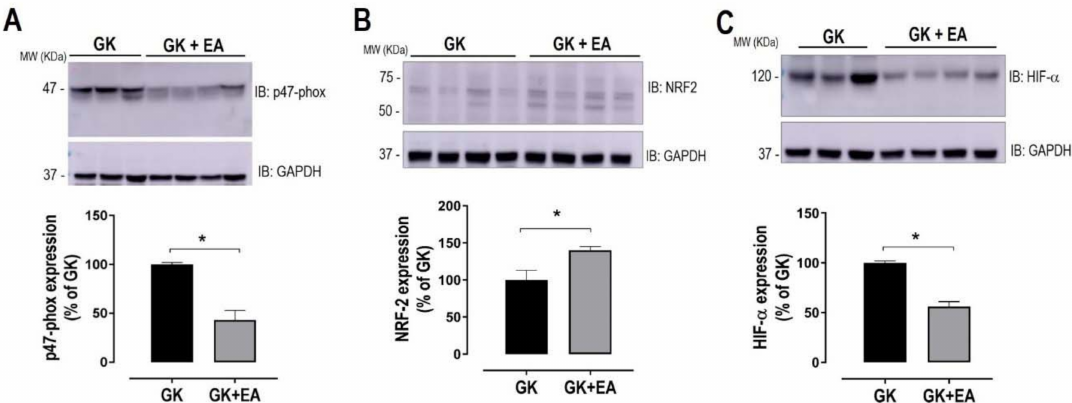
Figure 5. EA treatment reduces stress reduces stress machinery in diabetic livers. Expression of p47-phox ( A ), antioxidant transcription factors, NRF2 ( B ) and HIF- α ( C ) and in hepatic homogenate from diabetic GK rats with or without treatment with EA (50 mg/kg) for 45 days. Top panels: representative blots. Bottom panels: densitometry analysis. GAPDH was used as loading control. Data are presented as mean ± SEM; * p < 0.05, ( n = 6 per